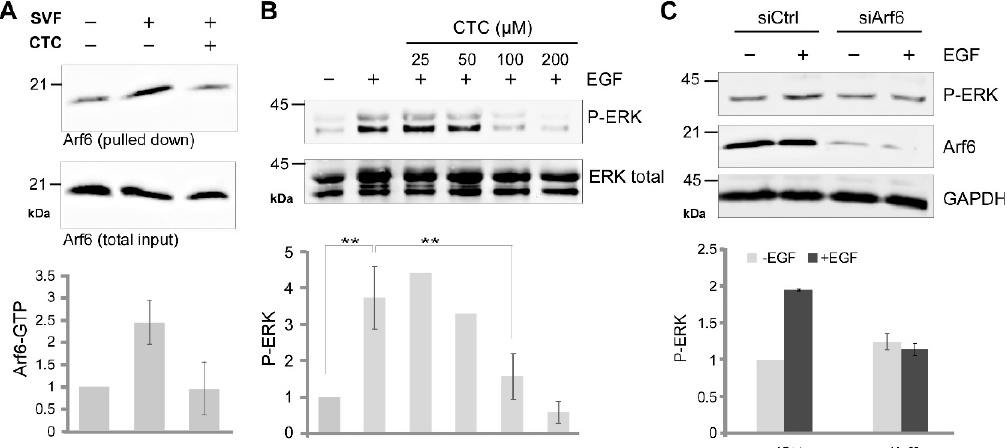
Figure 5. CTC blocks EGF-induced MAPK phosphorylation. ( A ) Serum-induced Arf6GTP loading was measured in starved RPE-1 cells with or without treatment with CTC (100 µM) for 2 h (n = 3). The amount of Arf6GTP was determined as described in experimental procedures. Arf6 western blot was quantified on the bottom panel. ( B ) After starvation, RPE-1 cells were pre-treated with different CTC concentrations for 2 h and activated or not with EGF (50 ng/mL) for 15 min. P-ERK western blot was quantified on the bottom panel (n = 3, 0.001 < ** p < 0.01). ( C ) RPE-1 cells were transfected with non-relevant siRNA (siCtrl) or anti-Arf6 siRNA (siArf6) for 3 days and stimulated or not with EGF (50 ng/mL). P-ERK western blot was quantified on the bottom panel (n = 3).